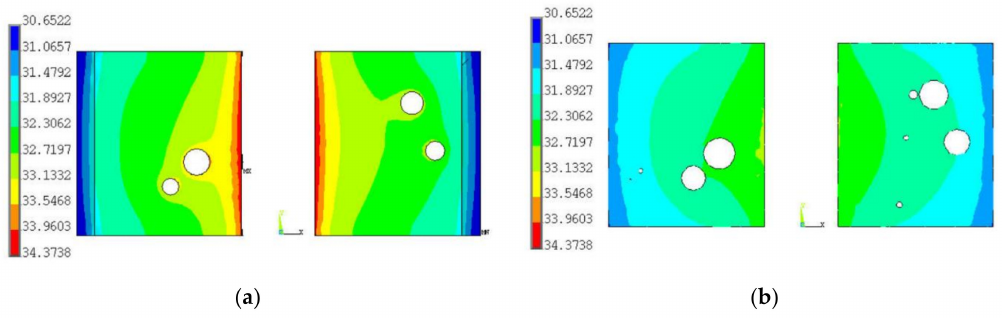
Figure 8. ( a ) The temperature distribution of solder joint; ( b ) the Z axis cross section of solder layers.